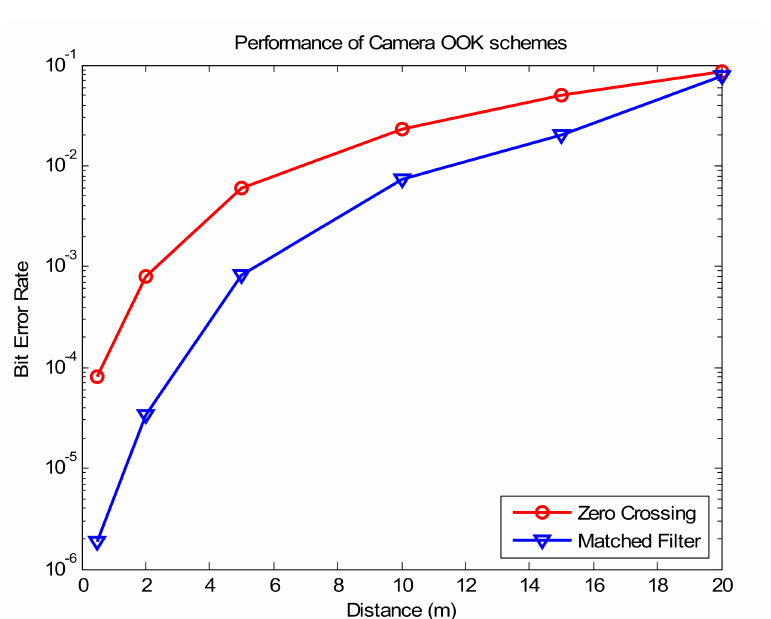
Figure 17. BER of the COOK system with an exposure time of 100